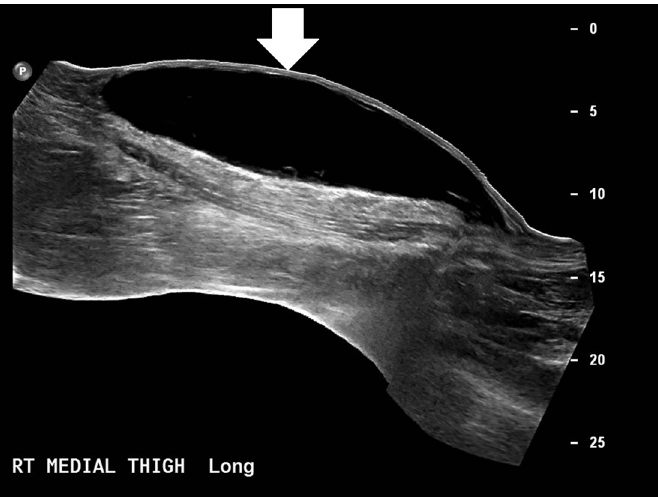
Figure 1. Morel-Lavallee lesion sonography with extended field of view along the long axis of the lesion shows fusiform shape and anechoic texture.